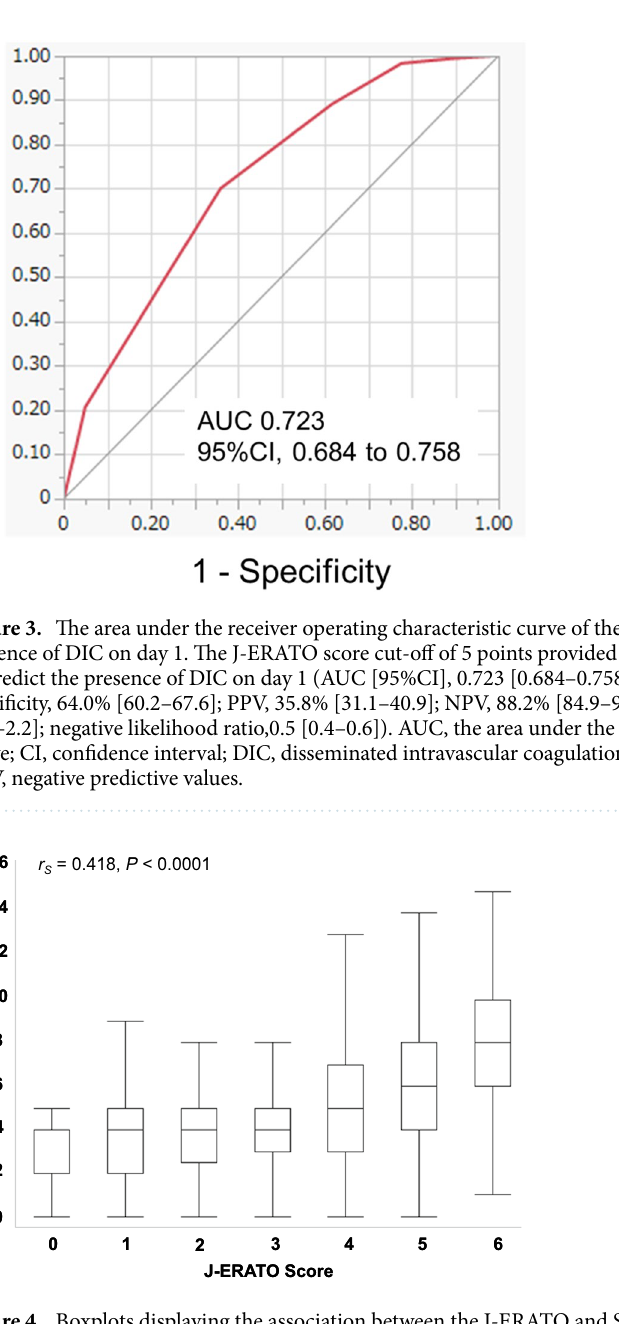
Figure 4. Boxplots displaying the association between the J-ERATO and SOFA scores on the first day after hospital admission. In total, 937 patients were included in the analysis. The numbers of patients in the J-ERATO score groups of 0, 1, 2, 3, 4, 5, and 6 were 19, 75, 97, 140, 224, 302, and 80, respectively. A significant linear trend was observed between the J-ERATO and SOFA scores on day 1 (Spearman’s rank correlation coefficient [ r S ] = 0.418, P < 0.0001). J-ERATO, early risk assessment tool for detecting clinical outcomes in patients with heat-related illness; SOFA: Sequential Organ Failure